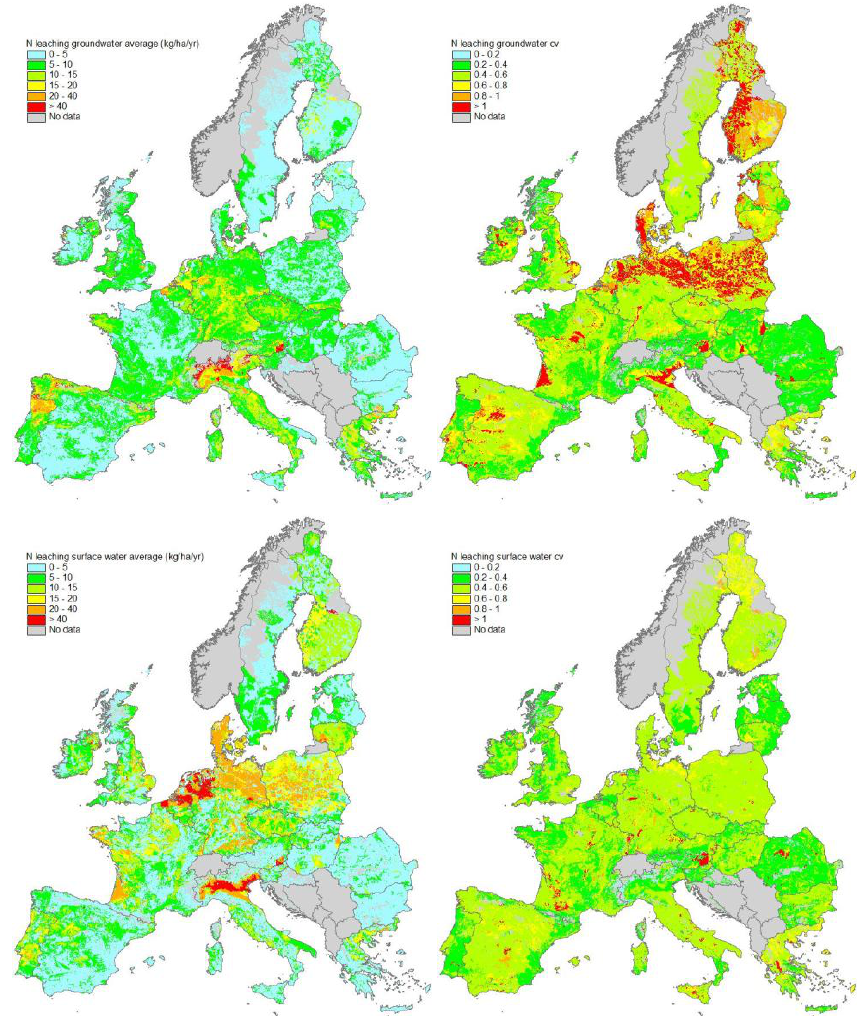
Fig. 5. The mean (left) and CV (right) of the area-weighted average N le groundwater (top) and N ro surface water (bottom) (in kg N ha − 1 yr − 1 ) per NCU for the year